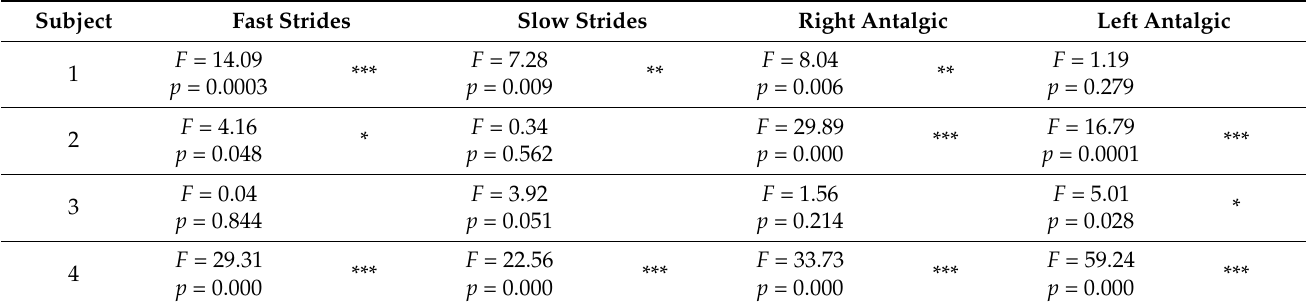
Table 8. Detection of Abnormal or Irregular Strides using Leg Gap Variability (Levene’s test) .